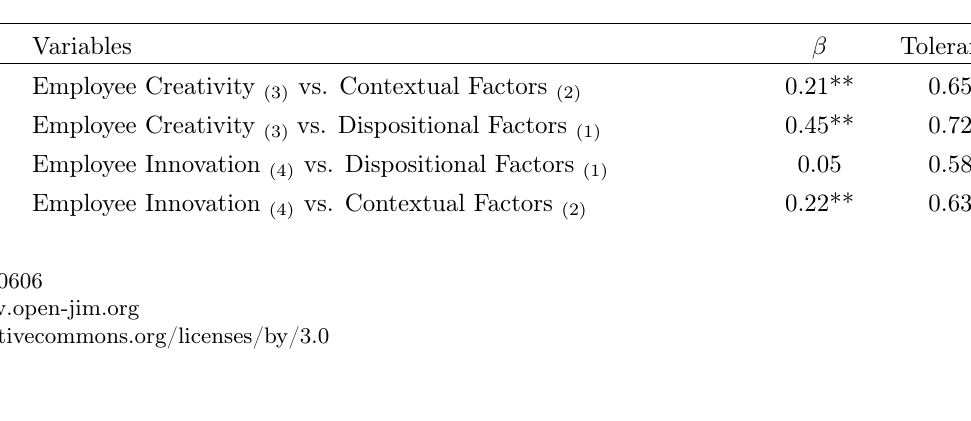
Table 6: Path Coefficients of the Included and Missing Paths for the Exogenous and Endogenous Factors in the Hypothesised Model in Figure